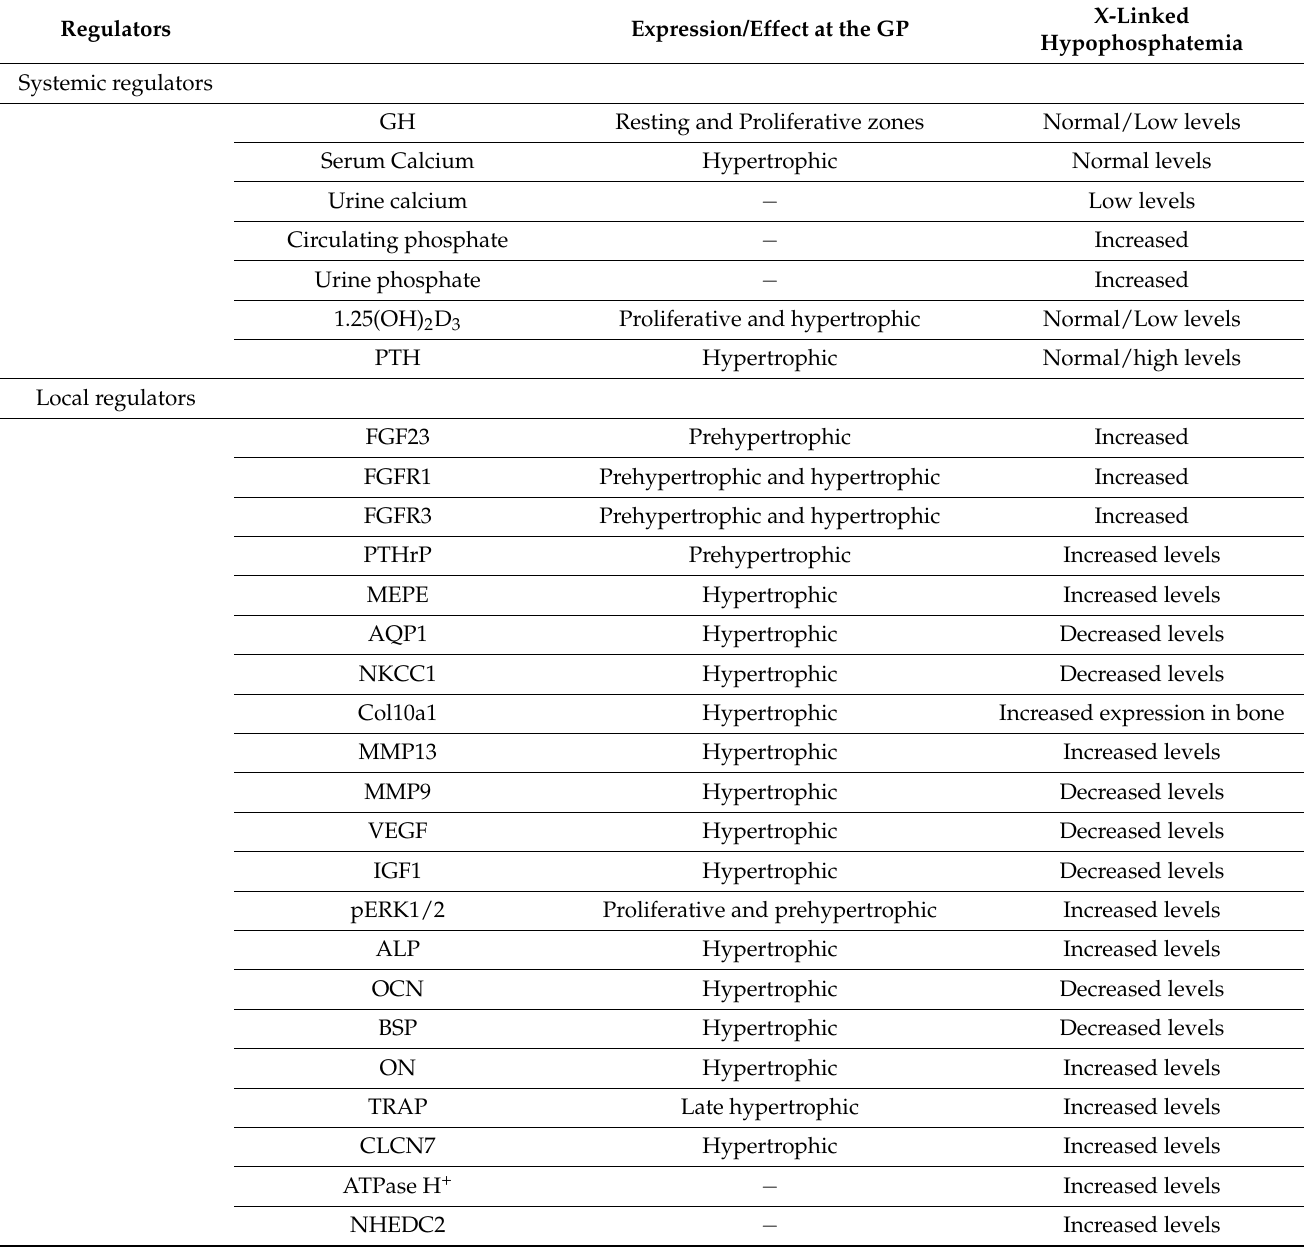
Table 3. Molecular factors implicated in the pathogenesis of the XLH growth plate